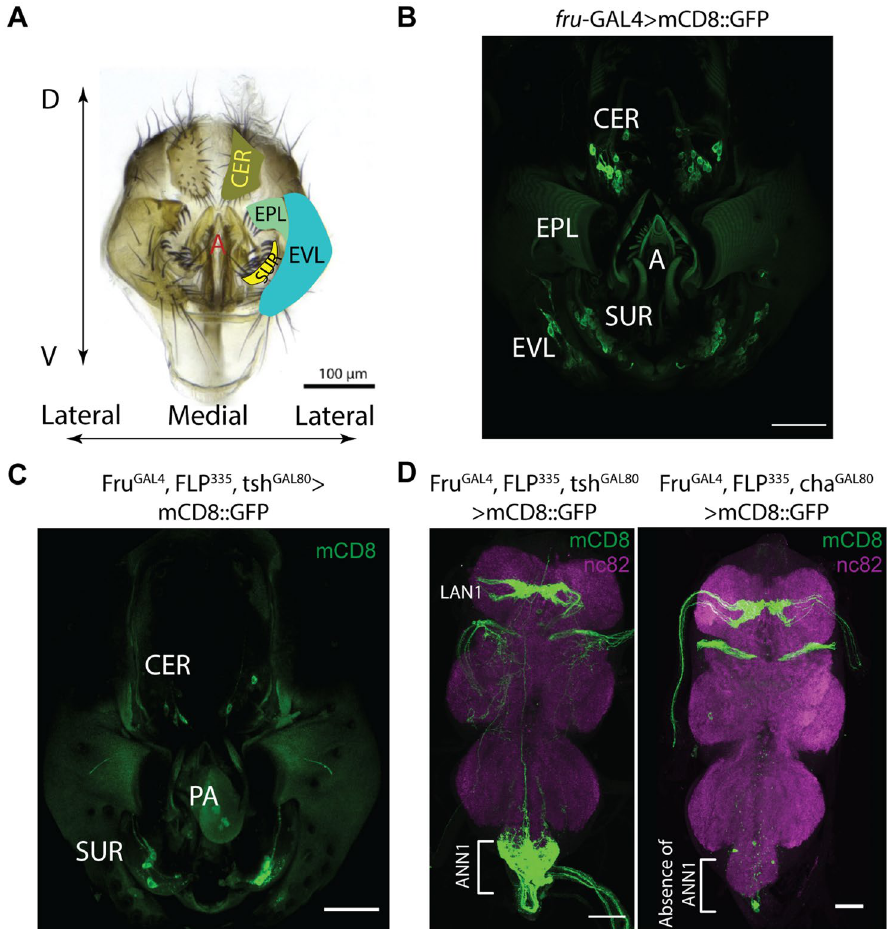
Figure 2. Characterization of fru neurons in the male genitalia. ( A ) Light microscope image of a male genitalia adapted from a previous work 21 . The male genitalia are comprised of the periphallic structures: cercus (CER), surstylus (SUR), epandrial ventral lobe (EVL) and the phallic structures: aedeagus ( A ). The phallic structures are attached to copulatory muscles (Fig. 5) and located just anterior to the periphallic structures. Stereotypical bristles on the surface of these cuticular plates are innervated by mechanosensory neurons (MSNs) 23 . ( B ) fru MSNs at the male genitalia. Expression profile of fru-GAL4 driving UASmCD8::GFP in the male genitalia. Fru expression was observed in ~ 50% of MSNs at the epandrial ventral lobe, ~ 64% of MSNs at the surstylus, and ~ 61% of MSNs at the cercus (Table 2). ( C ) fru MSNs restricted by FLP335. Expression profile of fru-GAL4, UAS > stop > mCD8::GFP, FLP335, tsh-GAL80 in the male genitalia. Adding FLP335 eliminated mCD8::GFP expression in the epandrial ventral lobe and restricted expression at the surstylus and the cercus (Table 2). The autofluorescence and 488 signals were unmixed as described in “Materials and methods”. ( D ) fru MSNs are cholinergic. Expression profile of FruGAL4,FLP335,ChaGAL80 > mCD8::GFP in the male ventral nerve cord. Adding the transgene cha-Gal80, which inhibits GAL4 in cholinergic neurons, eliminated ANN1 expression that originated from the genitalia MSNs (compare to Fig. 1A,B). Only fru-Abg-1 and other neurons in the abdominal ganglion showed expression. Scale Bar = 50 µm.